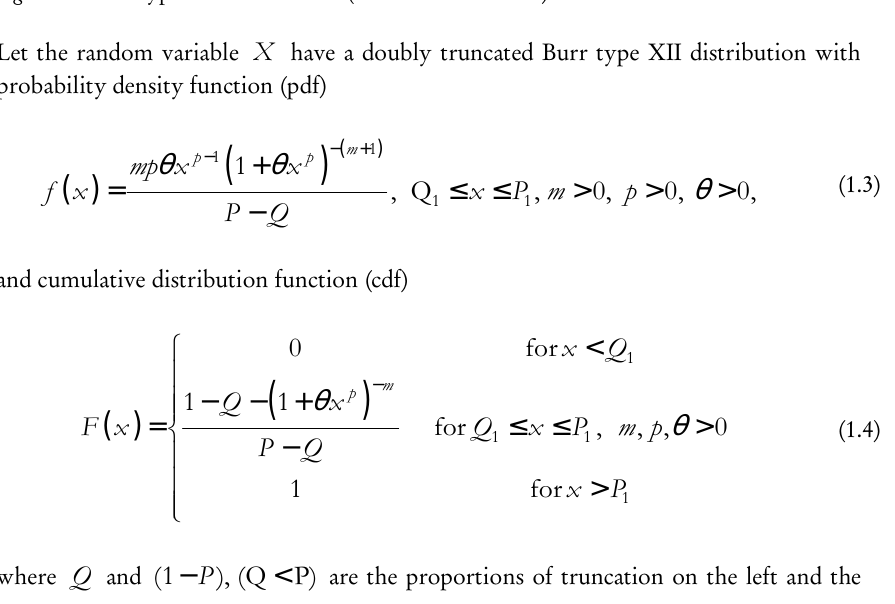
Figure 1 – Burr type XII Distribution (Non-Truncated